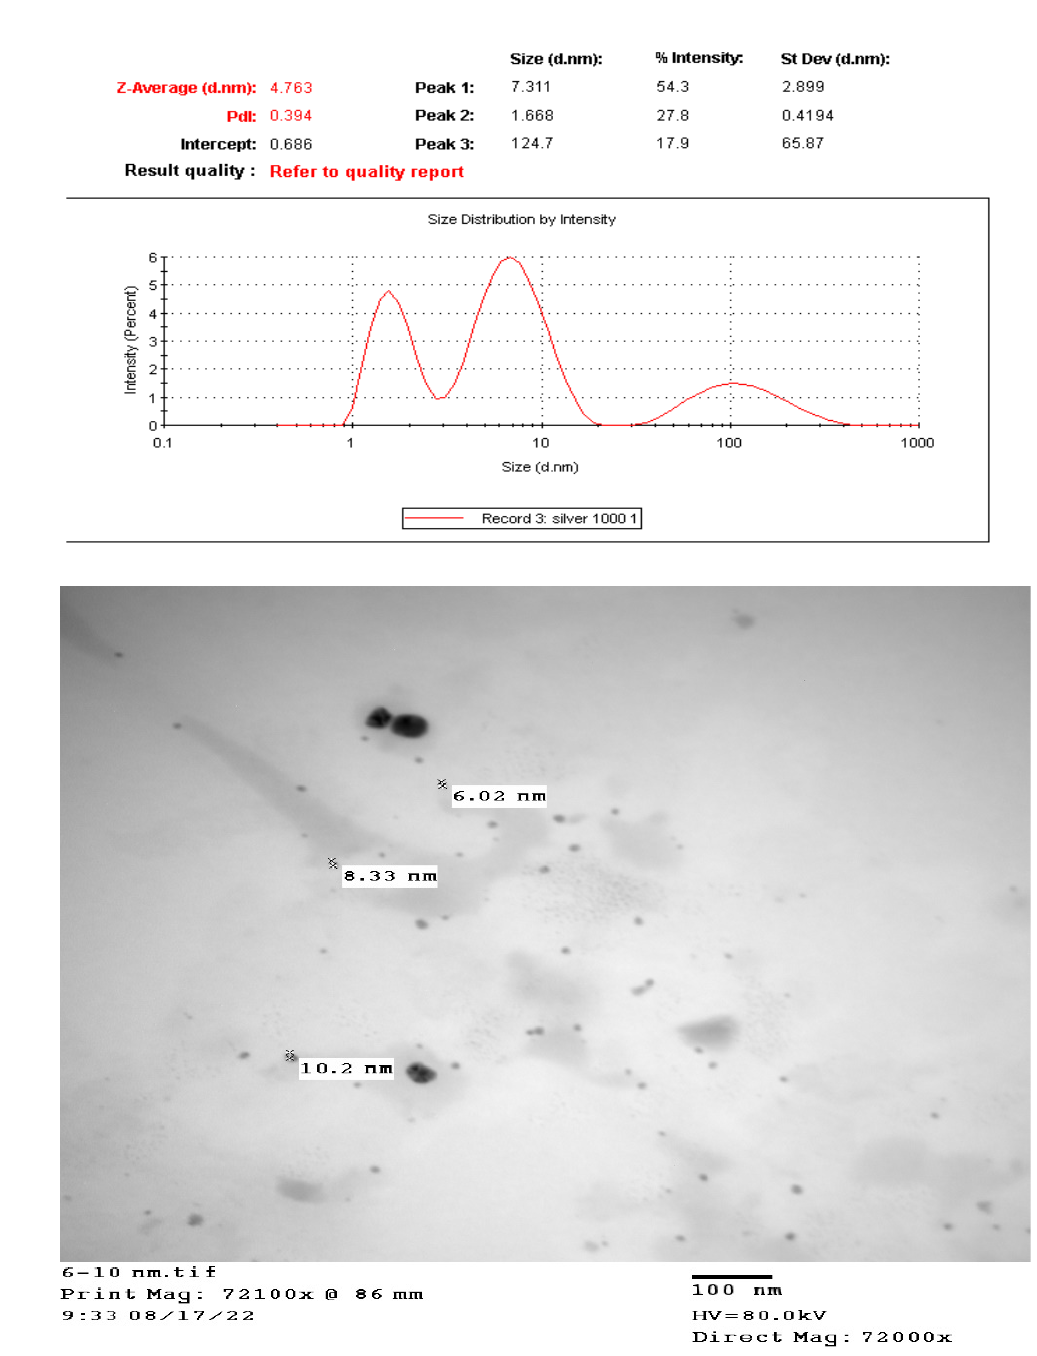
Figure 2. ( A , B ). Zeta-sizer and TEM micrograph of the synthesized PVP-AgNPs, respectively.